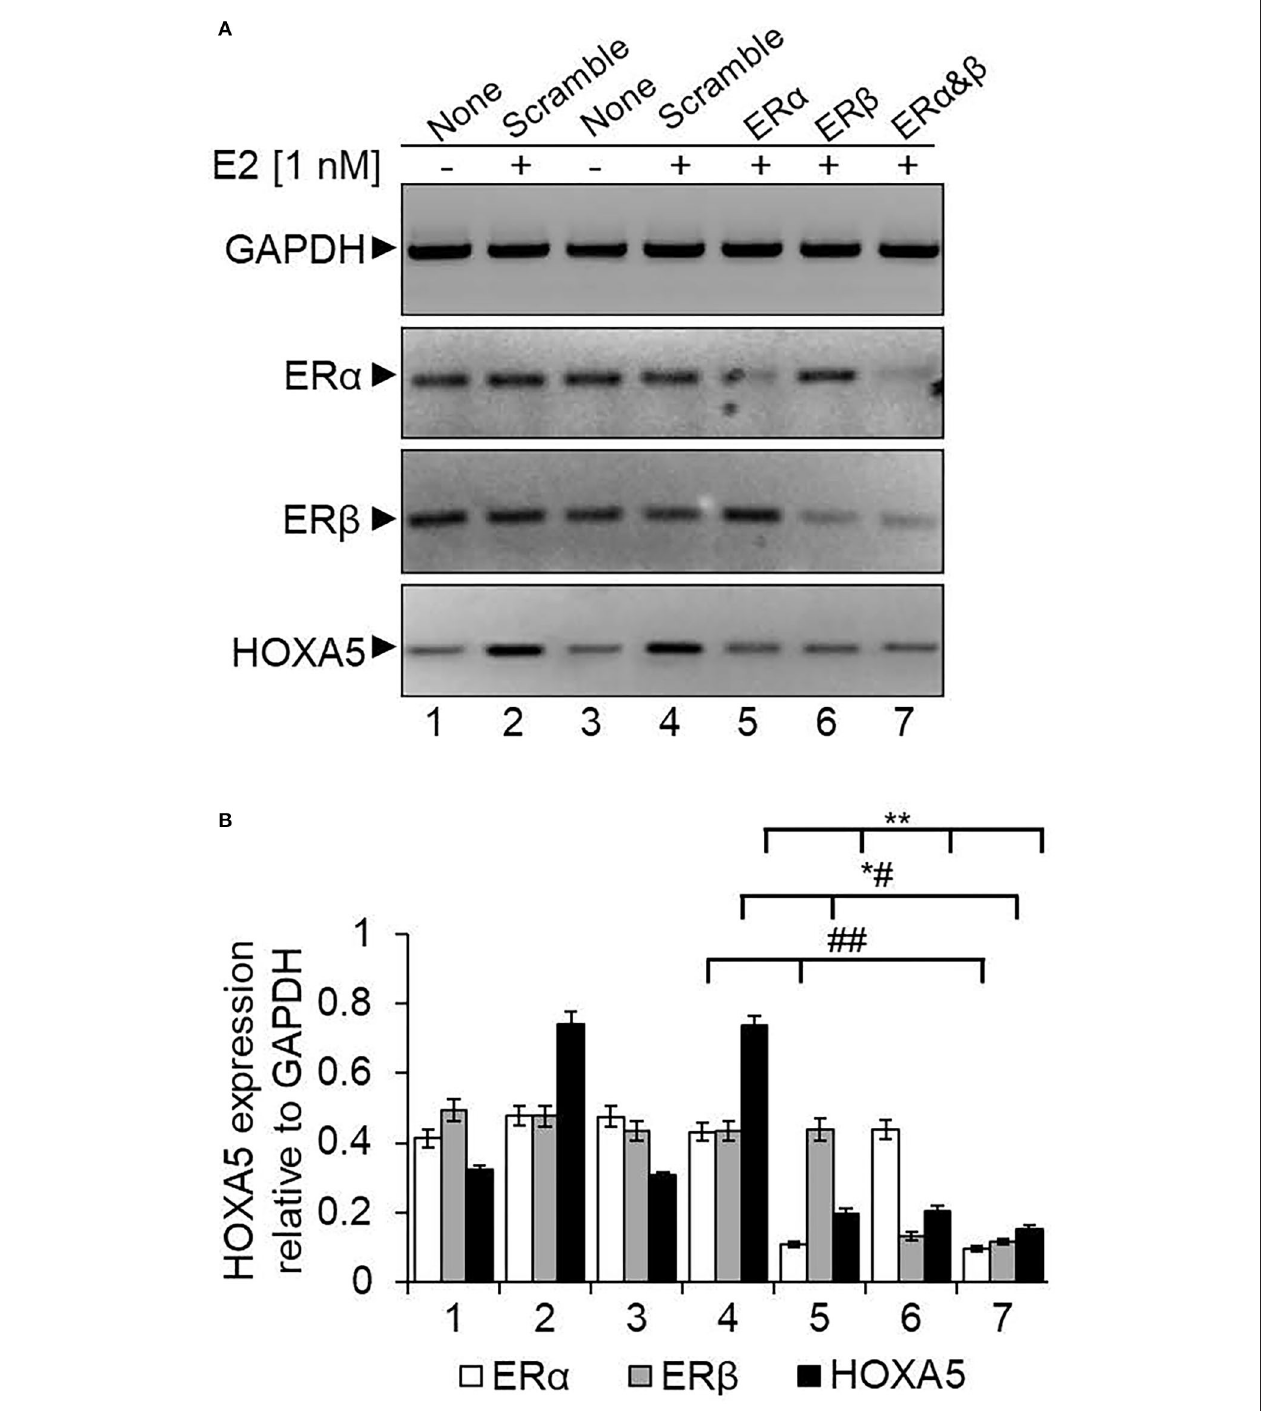
FIGURE 5 | Knockdown of ERs and its impact on E2-induced HOXA5 expression. MCF7 cells were transfected with ER α or ER β -specific ASOs or a scramble antisense for 48h, followed by treatment with E2 (1nM, 6h). RNA was analyzed by RT-qPCR by using primers specific to HOXA5, ERs, and GAPDH (control) separately (A) . Lane 1: control cells (no E2); lane 2: cells treated with E2; lanes 3 and 4: cells treated with scramble antisense in the absence and presence E2; lanes 5 and 6: cells treated with ER α and ER β antisense, respectively, followed by exposure to E2; lane 7: cells transfected with 1:1 mixture of ER α and ER β antisenses in the presence of E2. The qPCR analysis data is in (B) . qPCR reactions were carried out in three parallel replicates, and each experiment was repeated at least thrice ( n = 3). Bars indicate averages ± standard errors. **indicates p < 0.0001 compared to E2-treated scramble control (for HOXA5 target); * # indicates p < 0.0001 compared to E2-treated scramble control (for ER β target); ## indicates p < 0.0001 compared to E2-treated scramble control (for ER α target).